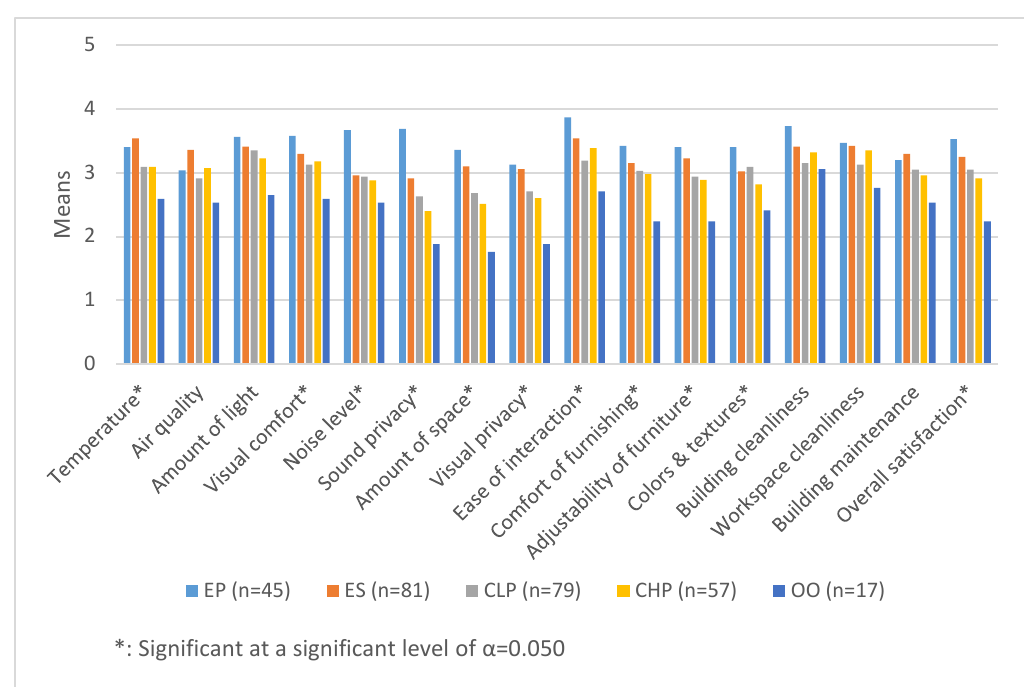
Figure 4. The impact of office layout on satisfaction with IEQ factors.